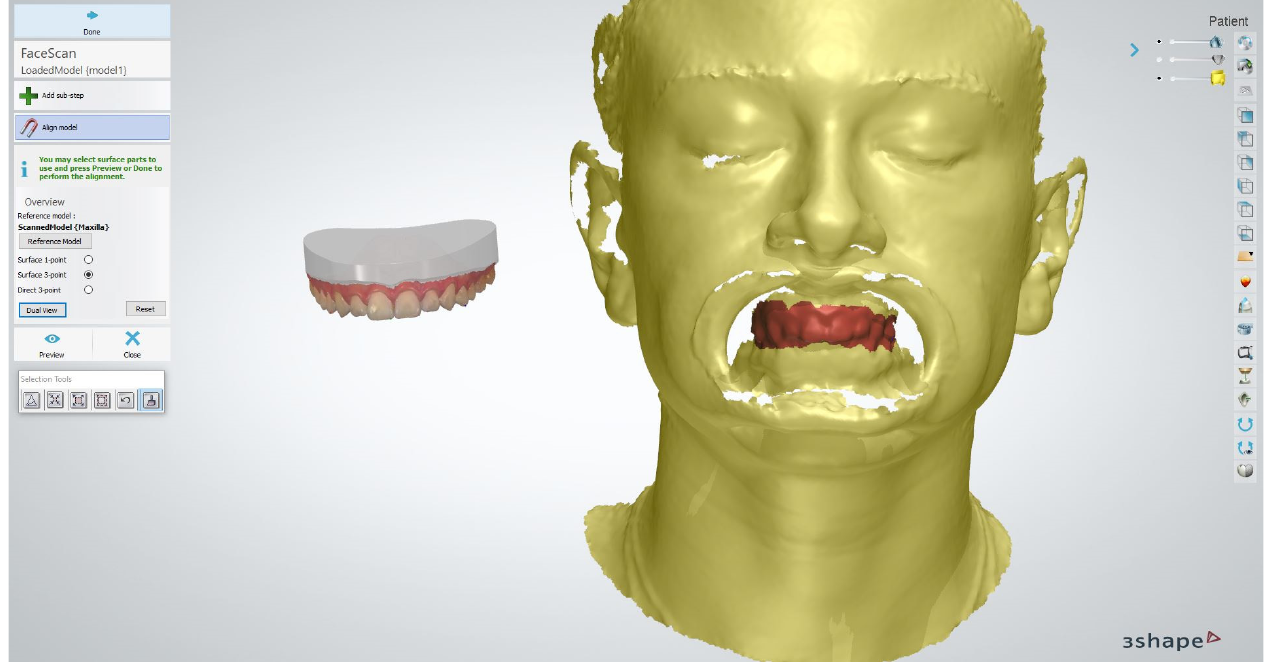
Figure 5. Matching the scan of the face with retractor with the upper arch.